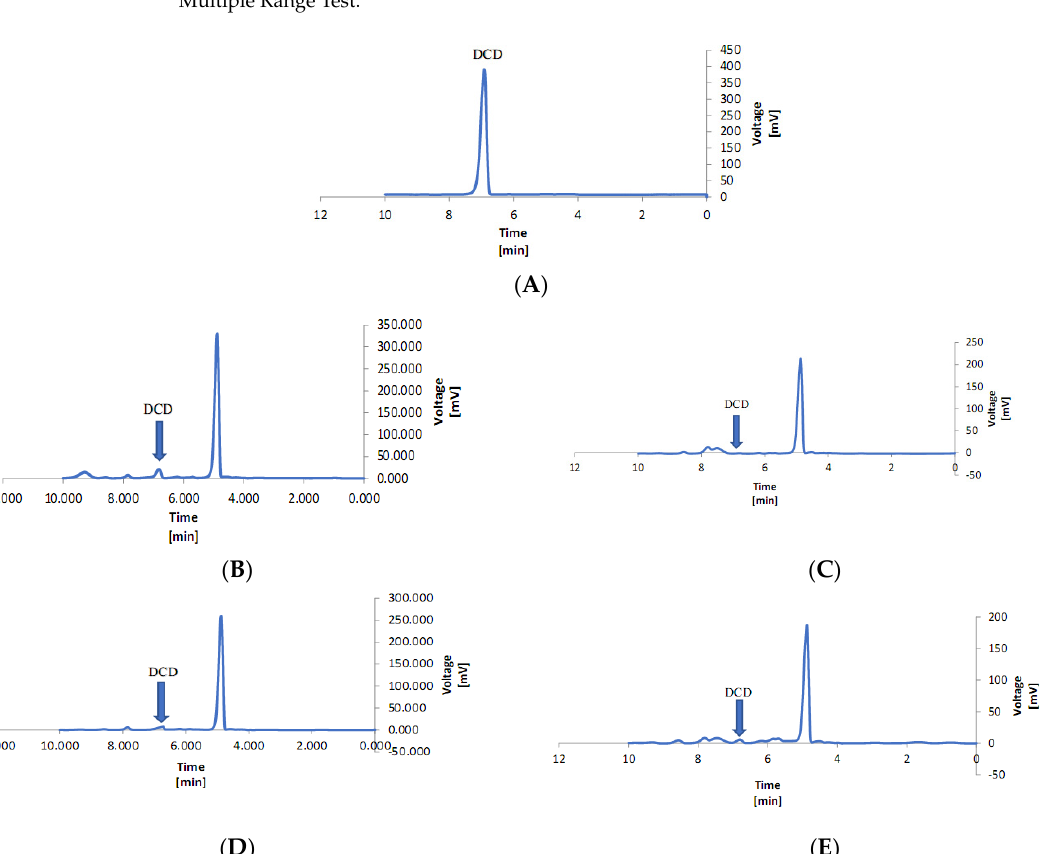
Figure 7. Effect of Piriformospora indica, Glomus mosseae , and Glomus etunicatum on the dicyandiamide content under different concentrations of dicyandiamide nitrification inhibitor in lettuce. (The means refer to four repetitions ± SD. Different letters for each parameter indicate significant differ- ences assessed ( p < 0.05).)